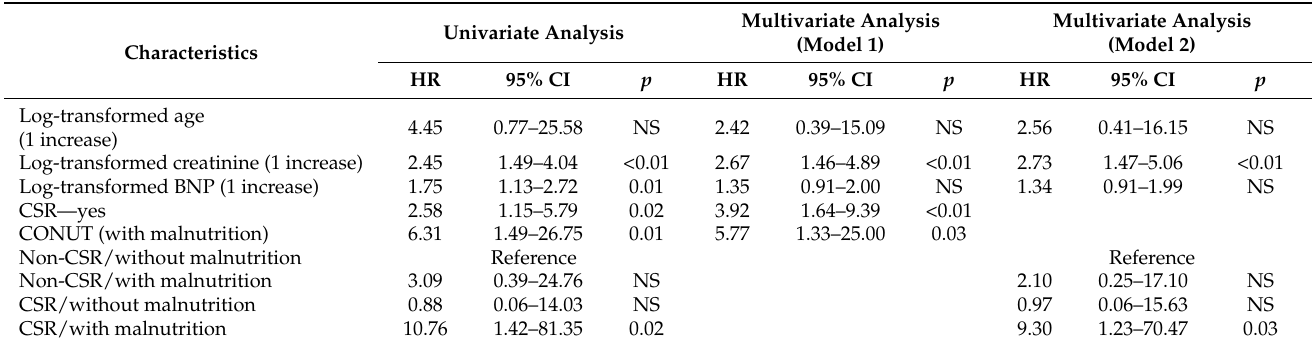
Table 2. Univariate and Multivariate Cox regression analysis on all-cause